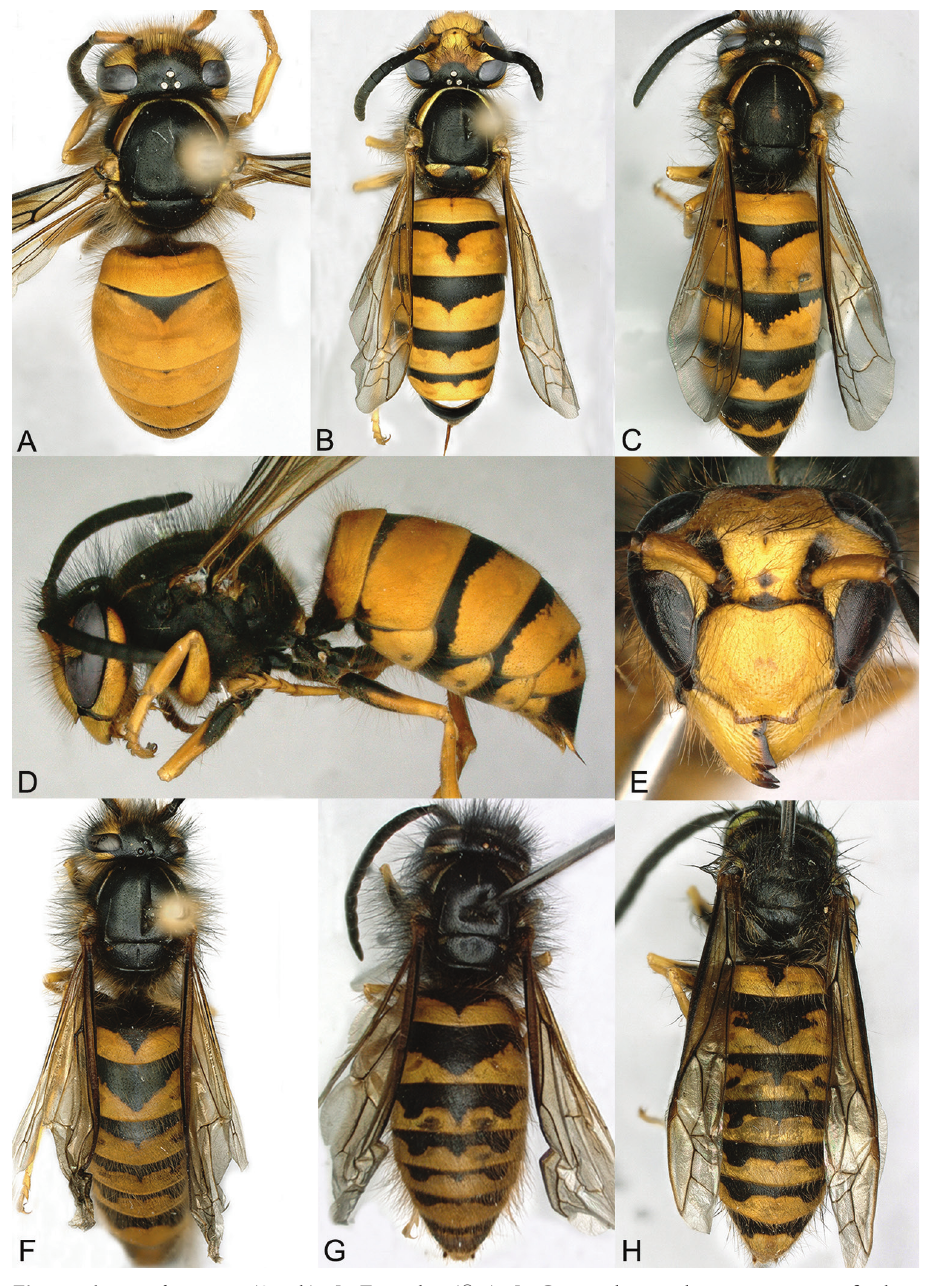
Figure 4. Vespula structor (Smith). A–E Worker ( ♀ w): A–C Dorsal view, showing variation of colour pattern D habitus, lateral view E head, anterior view. F–H Male ( ♂ ), dorsal view, showing variation of colour